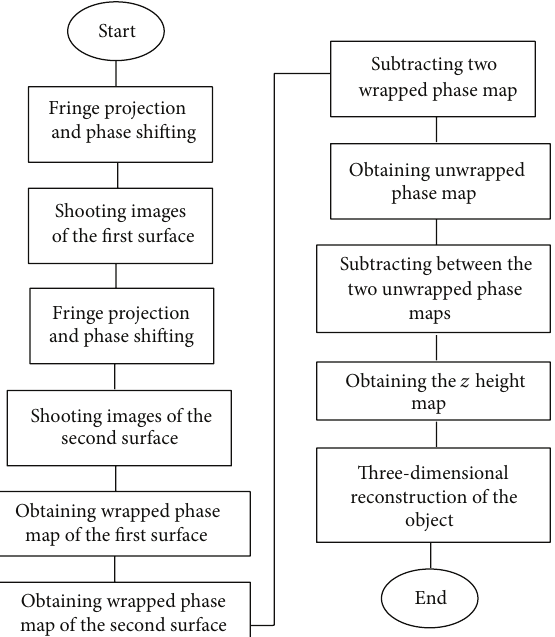
Figure 25: Algorithm for the three-dimensional